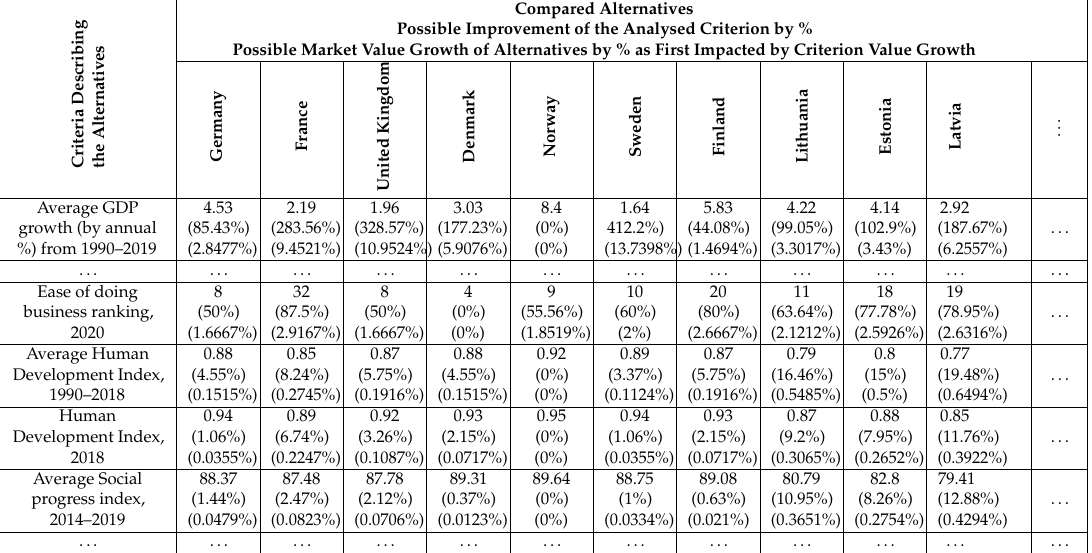
Table 4. A sample of digital recommendations on ways to improve certain scores for specific countries and the impact of the new scores on their cumulative position on the sustainable construction industry